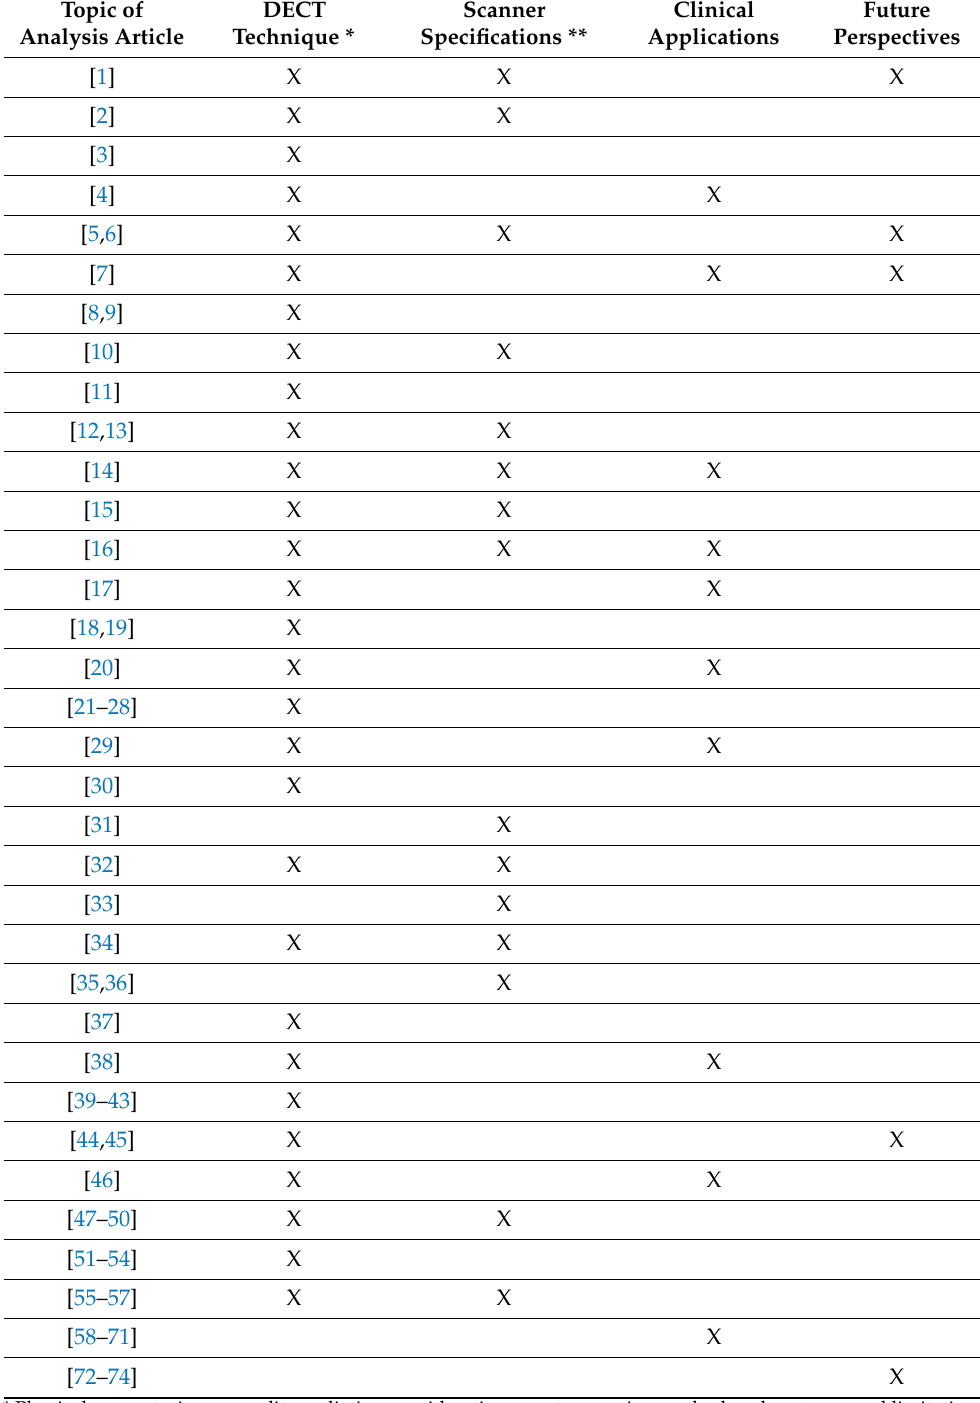
Table 1. List of studies included in the review (reference number), with indication of the topics of analysis for the current review